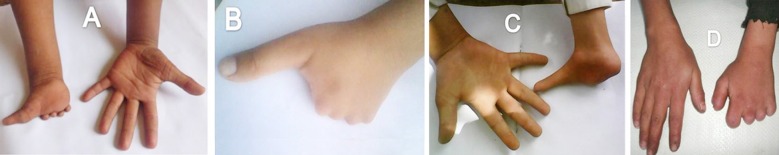
(A): Amputation in individual III; (B): individual IV; (C): individual V. (D); individual VI.